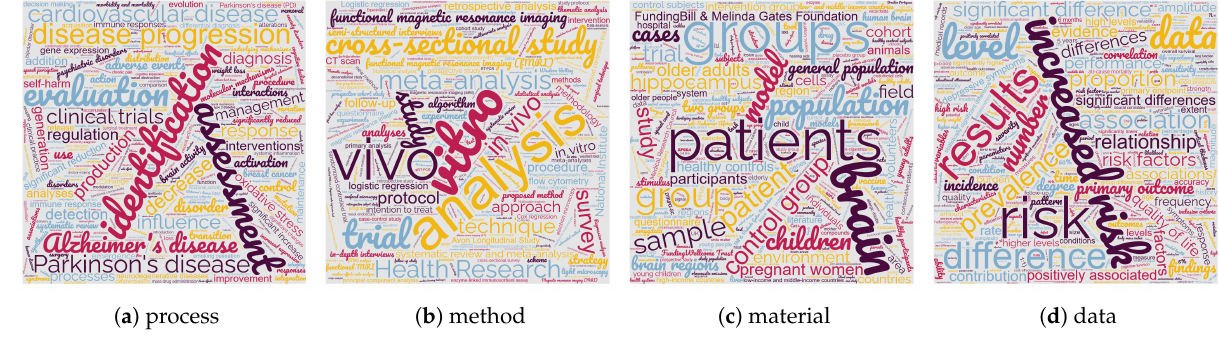
Figure 10. Medicine domain word